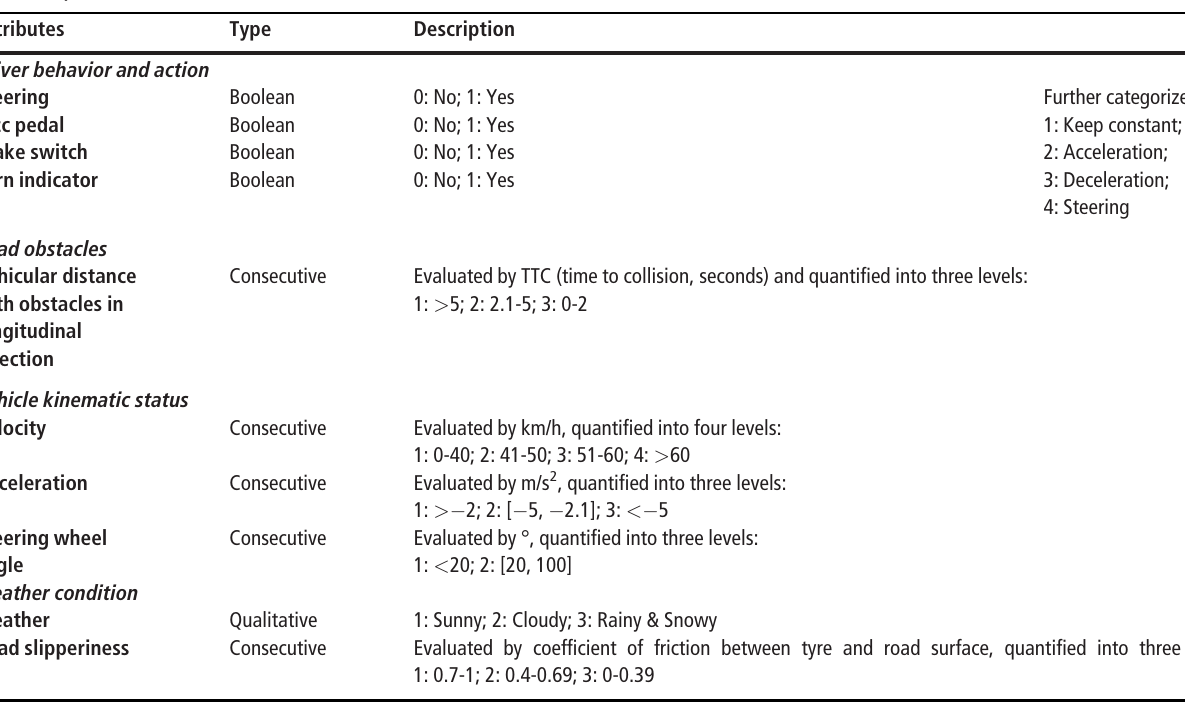
Table III Quantitation of